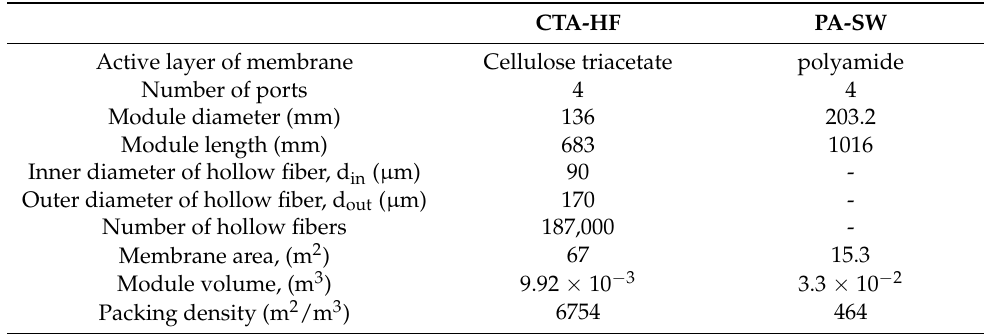
Table 1. Specifications of the cellulose triacetate hollow-fiber (CTA-HF) and polyamide spiral-wound (PA-SW) membrane modules used in this study. CTA-HF PA-SW Active layer of membrane Cellulose triacetate polyamide Number of ports 4 4 Module diameter (mm) 136 203.2 Module length (mm) 683 1016 Inner diameter of hollow fiber, d in ( µ m) 90 - Outer diameter of hollow fiber, d out ( µ m) 170 - Number of hollow fibers 187,000 Membrane area, (m 2